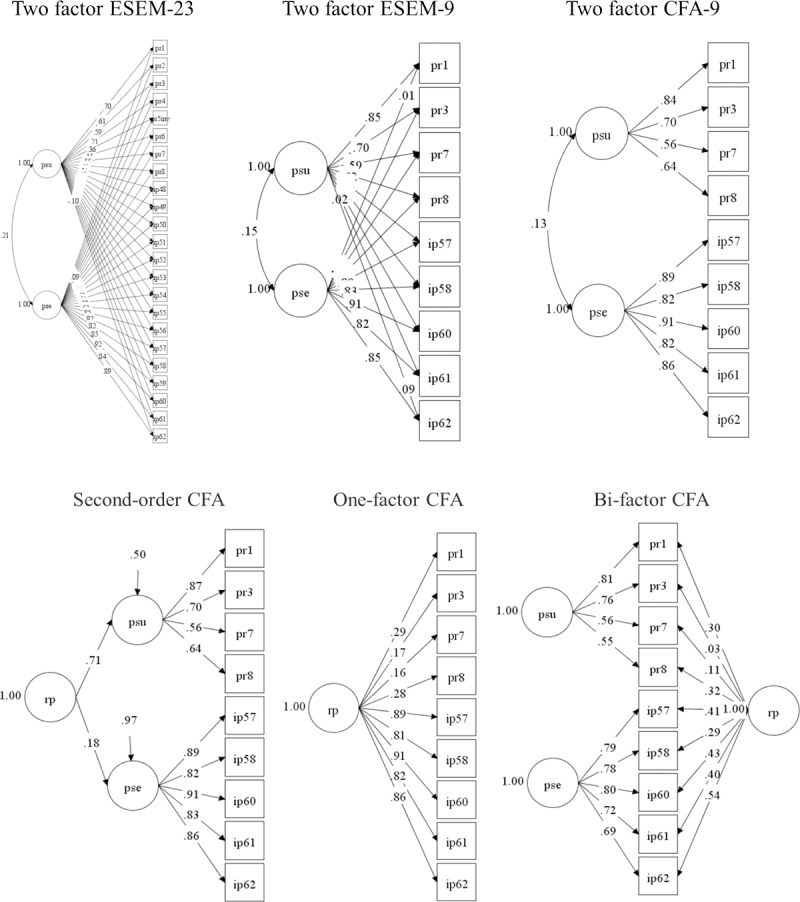
a. Graphical representation of the M1, M2a and M2b models. b. Graphical representation of the M3, M4 and M5 models.